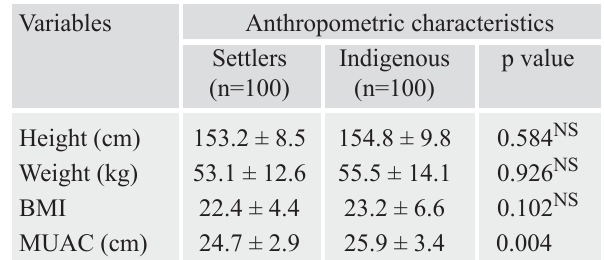
Table I: Distribution of the respondents by their socio-demographic characteristics (n=200)